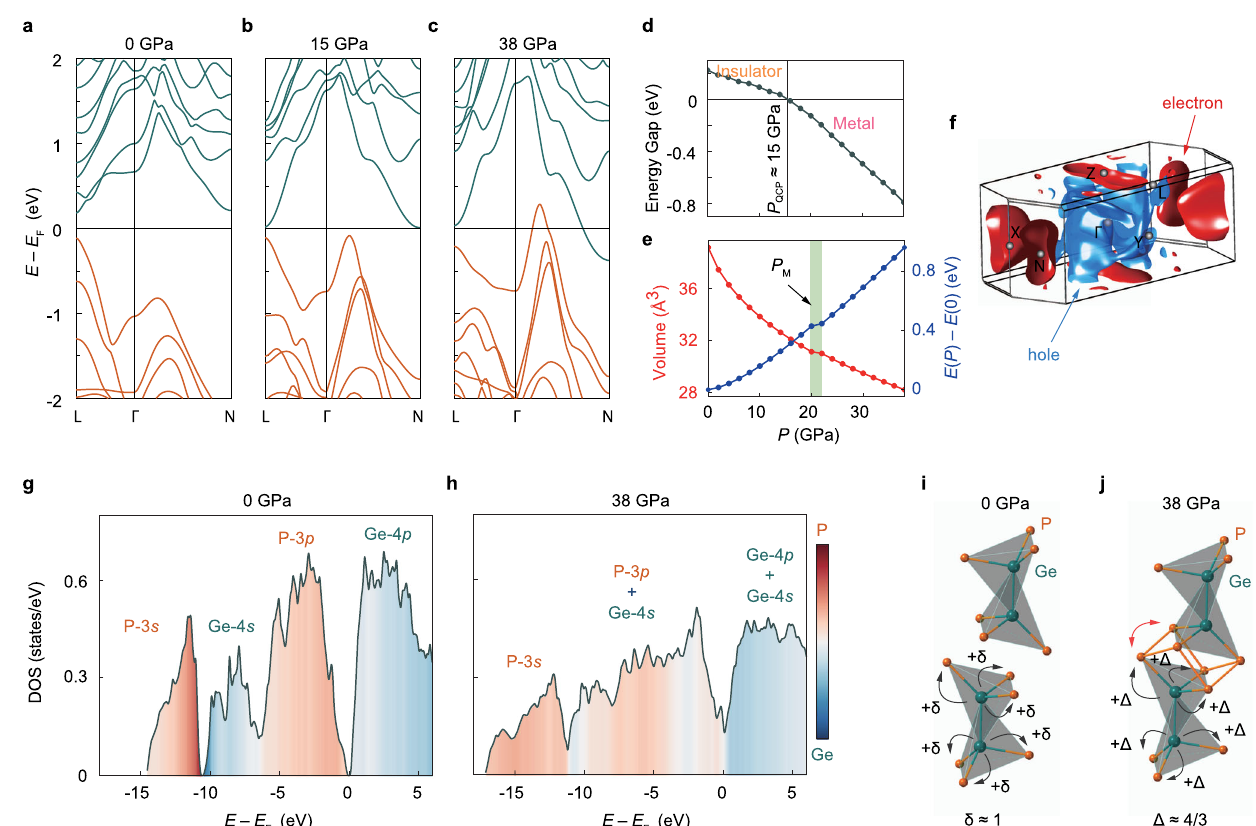
Fig. 3 | Electronic structure and valence-skipping evolution of GeP under pressure. The electronic band structure at a ambient pressure, b 15.0GPa and c 38.0GPa. d Thepressuredependenceoftheenergybandgap.Onecanseeaclear insulator-to-metal (superconductor) phase transition at the quantum critical pressure P QCP ∼ 15 : 0 GPa. e Differential free energy E P ð Þ (cid:3) E ð 0 Þ (blue curve) and unit-cell volume per formula unit (red curve). The green shaded area corresponds to the pressure range within which a structural phase transition takes place at critical pressure P M based on the valence-skipping mechanism. f The